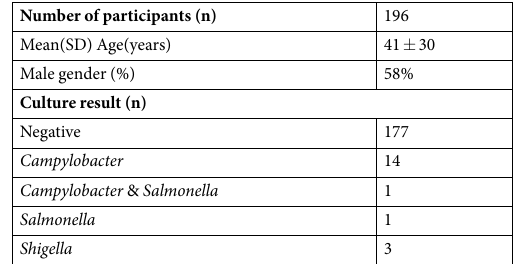
Table 1. Demographic characteristics and culture results of Israeli hospitalized